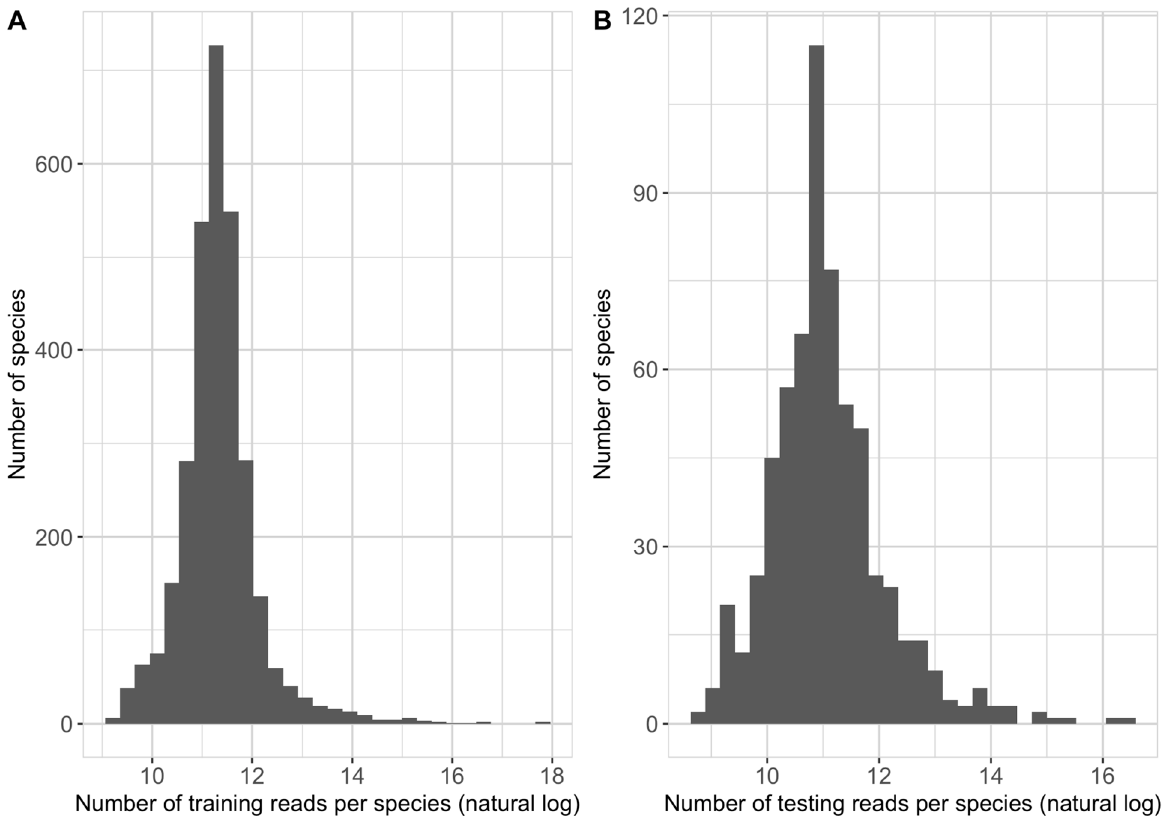
Figure 1. Distribution of number of training ( A ) and testing ( B ) reads per species based on the NCBI taxonomy in the natural log scale. taxonomy in the natural log